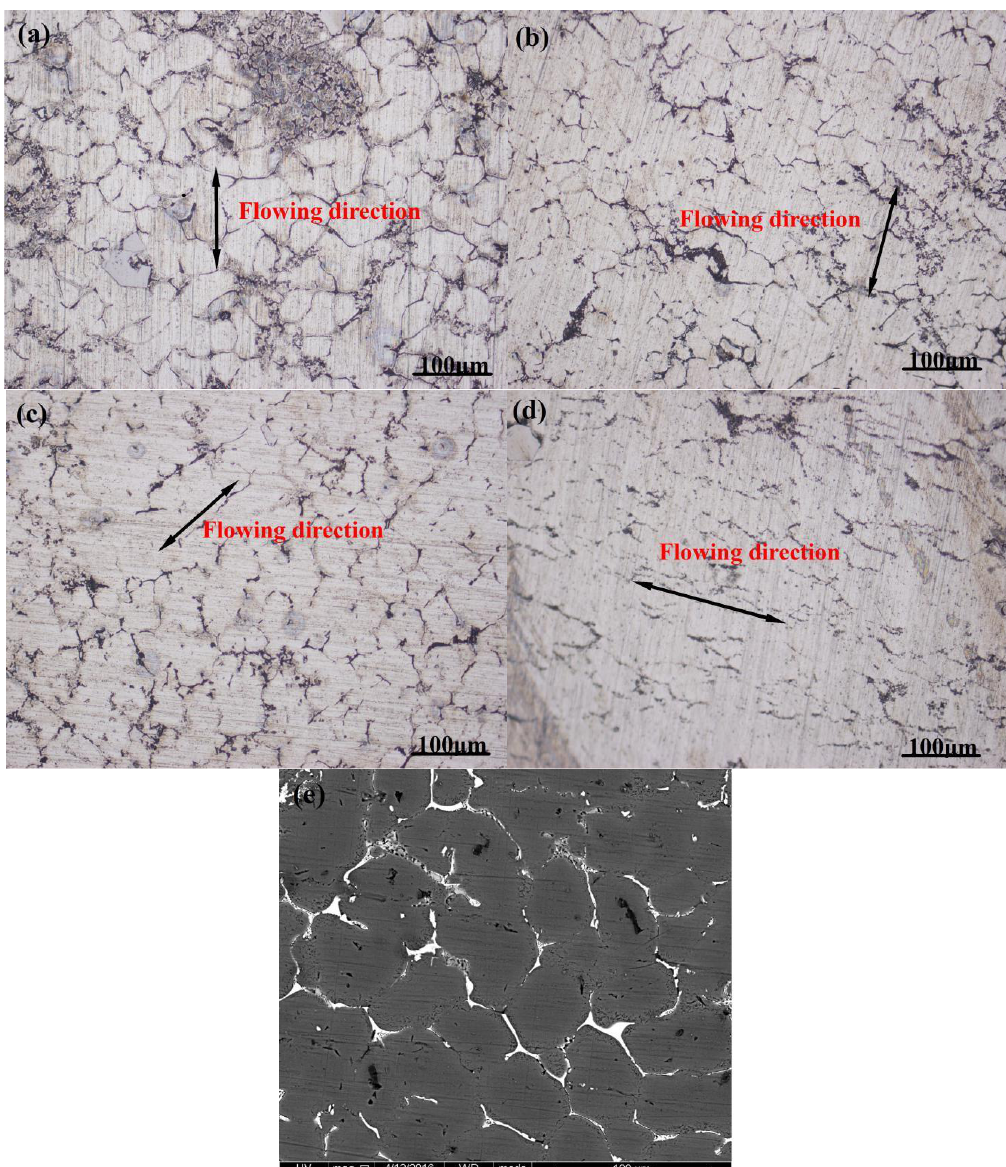
Figure 6. Microstructure of the original 2024 rheoformed at 620 °C and for 25 min stirring time. ( a ) OM image in location A of the matrix component; ( b ) OM image in location B of the matrix component; ( c ) OM image in location C of the matrix component; ( d ) OM image in location D of the matrix component; ( e ) SEM image in location B of 2024 matrix component.